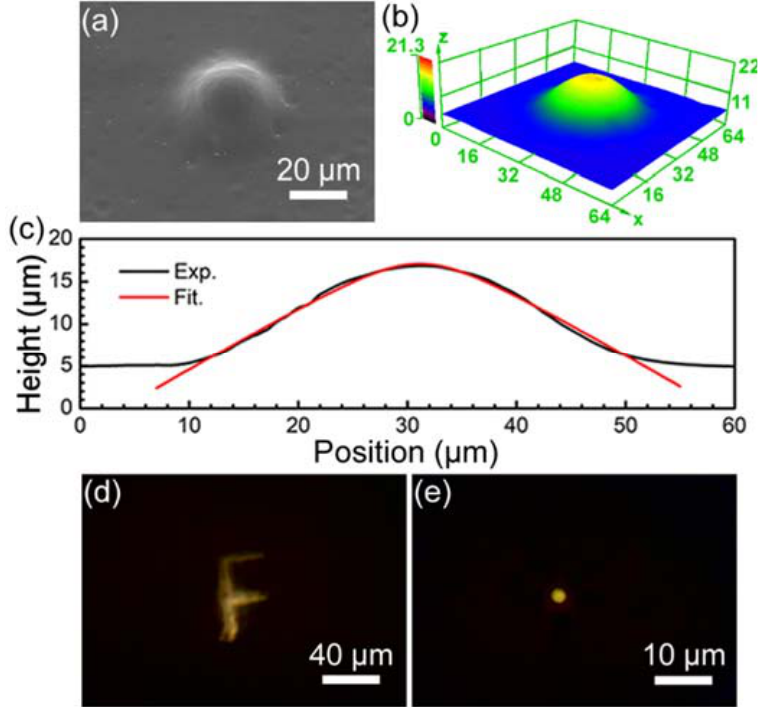
5 of 8 of an axisymmetric aspheric lens in a right-angle coordinate system can be expressed by the following formula: (1) where x is the ordinate value at each point of the system, c is the curvature at the vertex of the microlens, and k is the conic coefficient of the aspheric surface. According to the different values of k, the aspheric surface shape can be divided into different types, in- cluding hyperbolic, parabolic, elliptical, and circular. Here, the red line in Figure 4c shows the fitted profile of the convex microlens in Figure 4a, which is consistent with the exper- imental data. According to the fitting results, the curvature at the vertex of the microlens (c) is approximately 0.1452, and the conic coefficient of the aspheric surface (k) is approx- imately − 2.76. When the value of k is less than − 1, the cross-section profile of the prepared